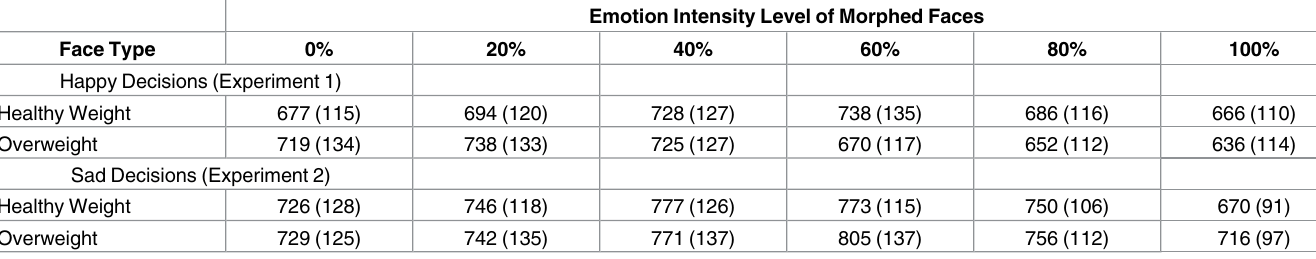
Table 2. Means and standard deviations of the response time in